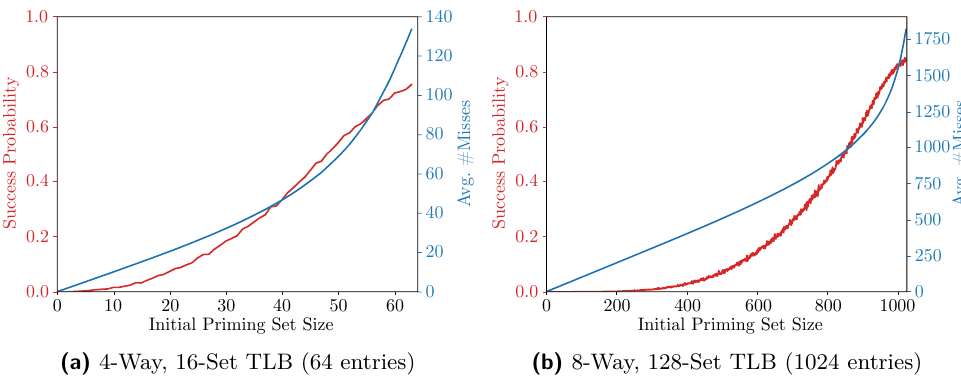
Figure 6: Catching probability and average number of misses for the prime and prune steps as a function of the initial probing set size for finding one translation conflict using the Prime+Prune+Probe attack. The modeled TLB uses the RPLRU replacement policy. It implements index-randomization but does not re-randomize the mapping during the